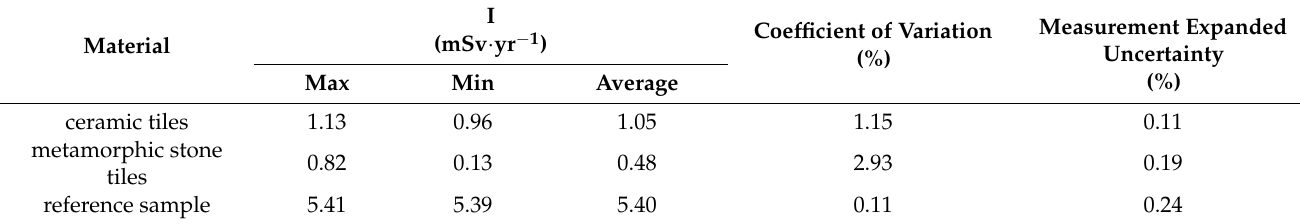
Table 6. Radioactivity concentration index measured for ceramic and stone